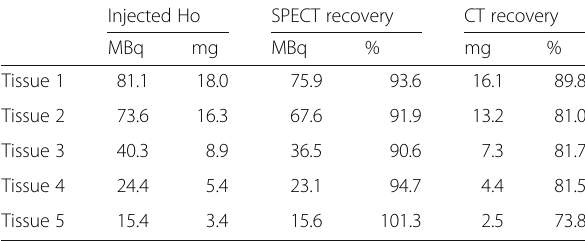
Table 2 E x vivo Ho recovery by single-photon emission computed tomography (SPECT) and computed tomography (CT) Injected Ho SPECT recovery